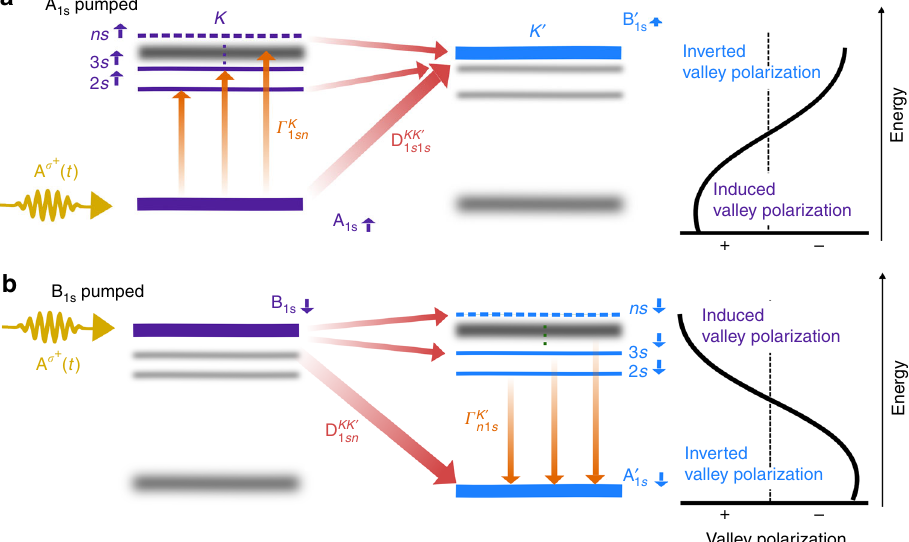
Fig. 1 Schematic illustration of Dexter-like intervalley coupling. The coupling of a spin-up and b spin-down states after resonant excitation of A 1s and B 1s exciton in the K valley, respectively. The applied circularly polarized light is denoted by the vector potential A σ + ( t ). The states of the corresponding opposite spin are blurred in the background. Higher excitonic B states are not shown for reasons of clarity, but they have been considered in the calculations. The optically excited 1 s state couples to higher excitonic states with the same spin in the same valley via the inter-exciton coupling Γ 1 sn . At the same time an intervalley Dexter-like coupling D KK ′ induces an intervalley oscillation transfer between A and B excitons generating a microscopic 1 sn polarization in the unpumped K ′ valley. This induces a frequency-dependent inversion of the optically induced valley polarization. Note that we denote the indirectly driven A and B excitons in the K ′ valley as A ′ and B ′